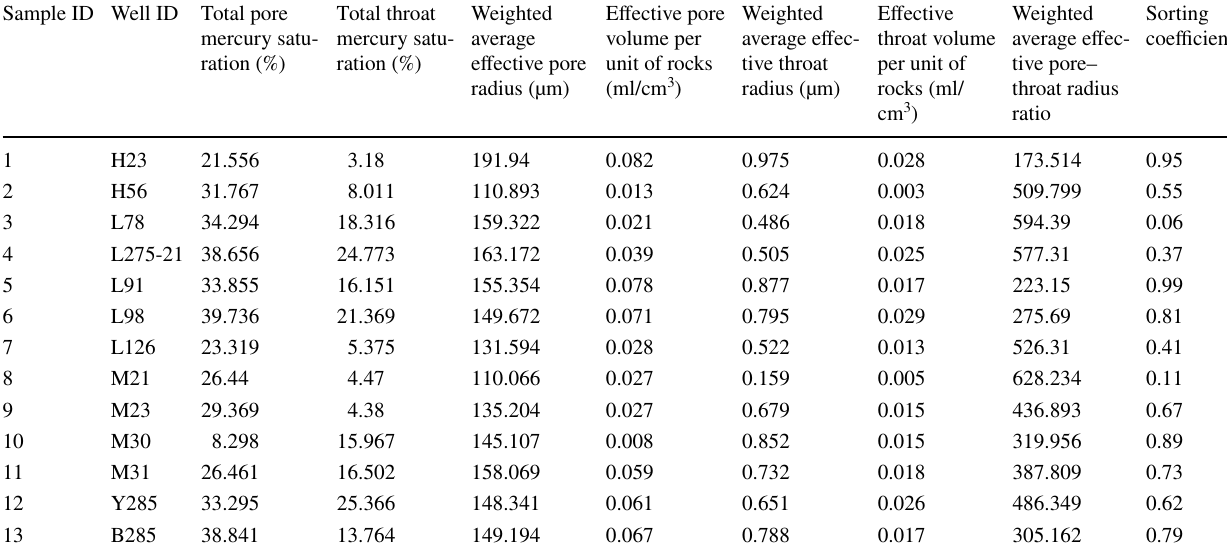
1 reservoir in Maling Oilfield